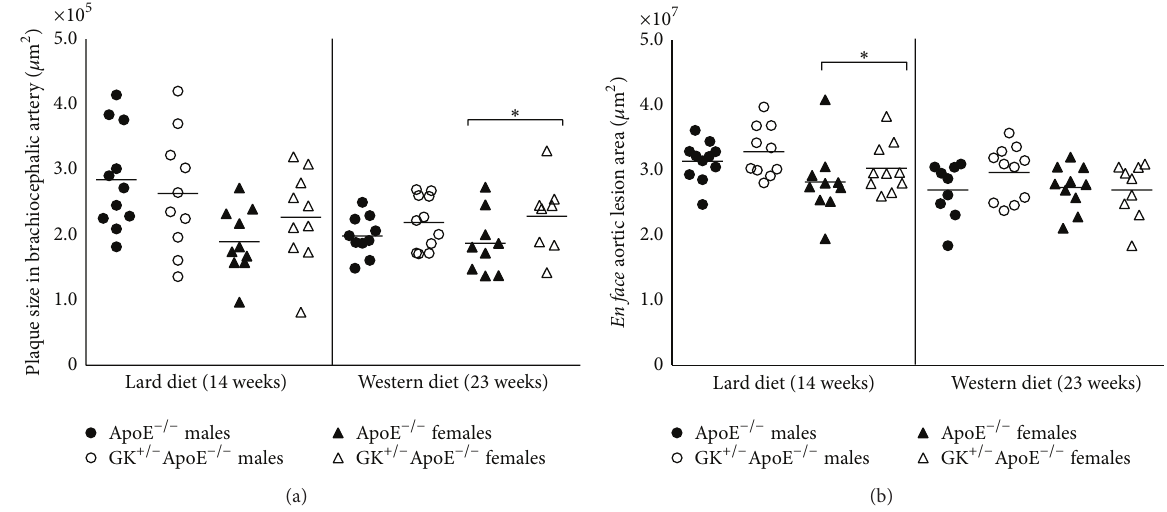
Figure 5: Histology evaluation of plaque size in the brachiocephalic artery (a) and en face lesion area in the thoracic aorta (b) measured in the atheroprogression study. There is a trend for GK +/− ApoE −/− mice to have greater plaque compared with the ApoE −/− , with female GK +/− ApoE −/− having a more consistent pattern. Statistical analysis was performed using 𝑡 -test and a 𝑝 value of less than 0.05 was considered significant. ∗ 𝑝 < 0.05